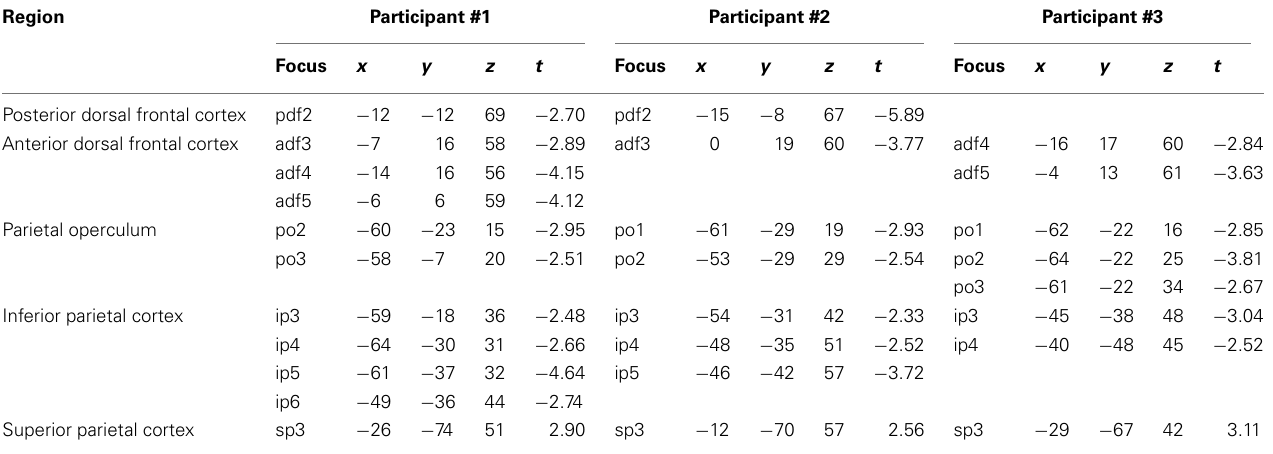
Table 2 |Active foci found with the ISI of